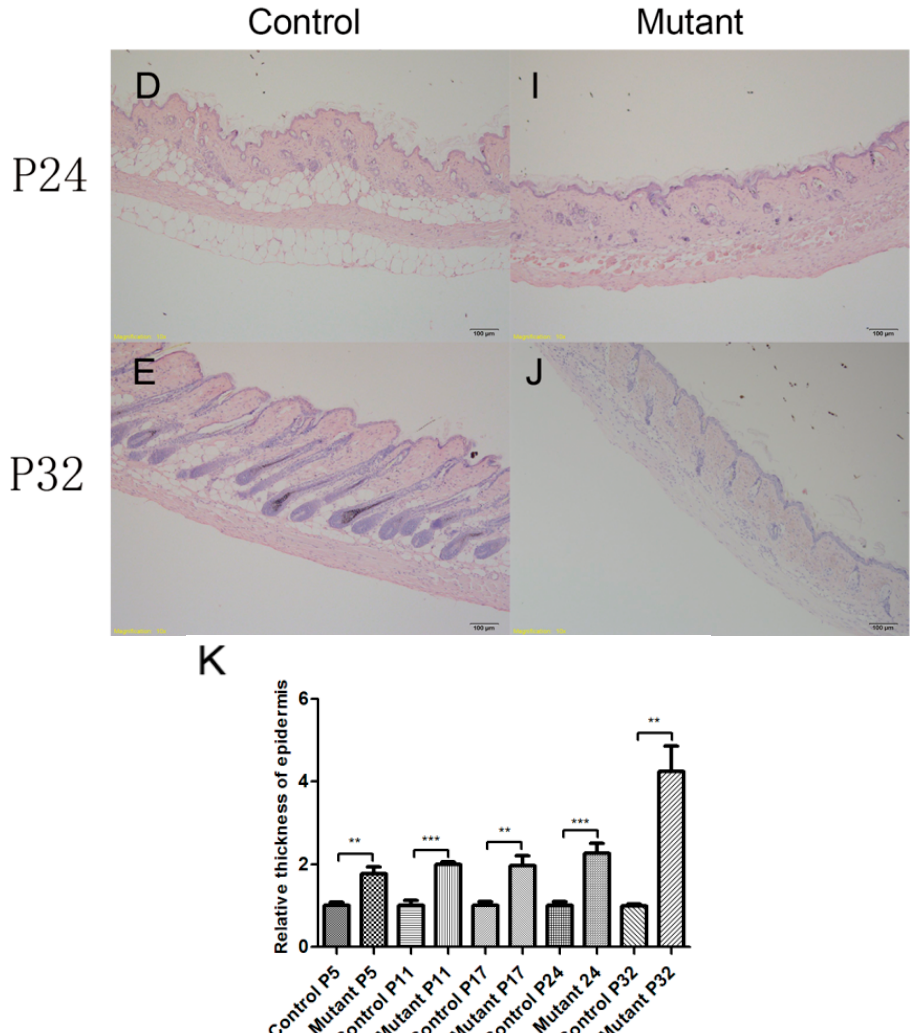
Figure 3. Disruption of the hair follicle cycle in Ppp2ca flox/flox ; Krt14-Cre mice. H&E staining of skin tissue sections from the control ( A – E ) and mutant ( F – J ) at P5 (panels A and F ), P11 (panels B and G ), P17 (panels C and H ), P24 (panels D and I ) and P32 (panels E and J ). At P5, hair